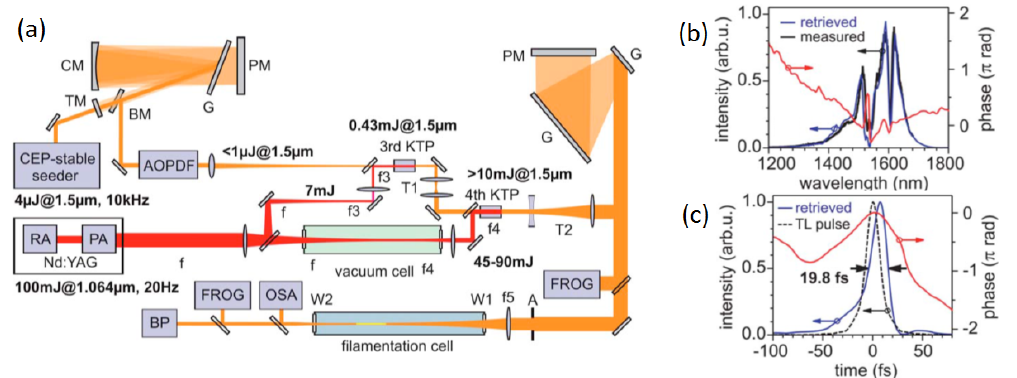
Figure 6. ( a ) Scheme of the Optical Parametric Chirped Pulse Amplification (OPCPA) setup for near IR pulses amplification. G, reflection Grating; CM, Curved Mirror; PM, Plane Mirror; TM/BM, Top/Bottom Mirror; AOPDF, Acousto-Optic Programmable Dispersive Filter; RA, Regenerative Amplifier; PA, double-pass Post-Amplifier; f, f3, f4, f5, lens Focal lengths; T1, T2, Telescopes; A, Aperture; W1/W2, input/output Windows; BP, Beam Profiler; ( b ) Measured (black) and retrieved spectral intensity (blue) and phase (red); ( c ) Temporal intensity profile corresponding to a pulse duration of 19.8 fs. Adapted with permission from [38], Copyright OSA Publishing,